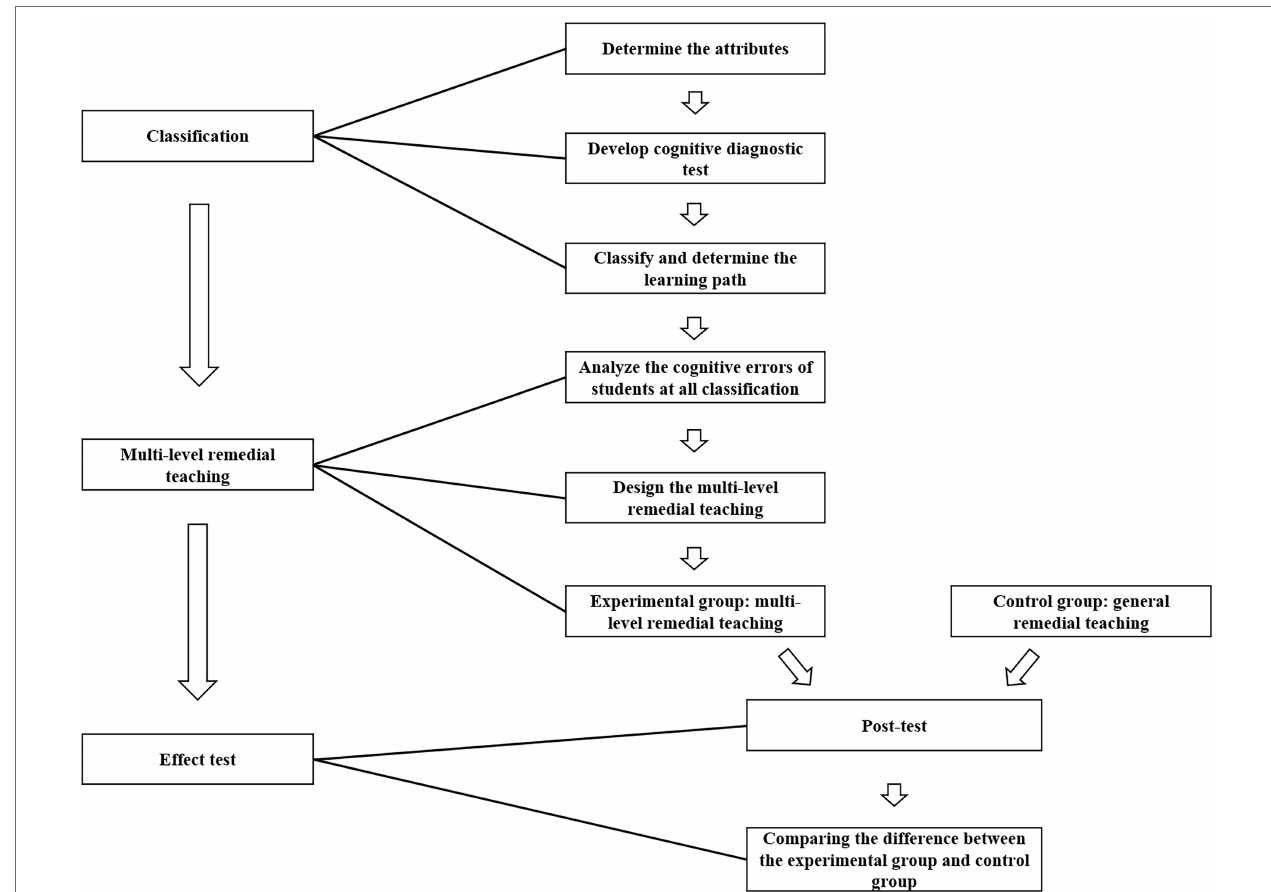
FIGURE 1 | The multi-level remedial teaching research